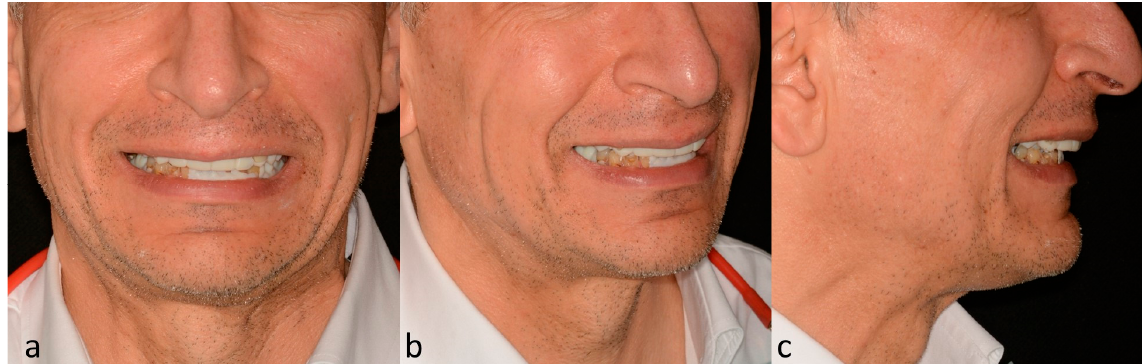
Figure 10. Extraoral evaluation of the 3D-printed overlays; ( a ) smile frontal view, ( b ) smile lateral view, and ( c ) smile profile view.